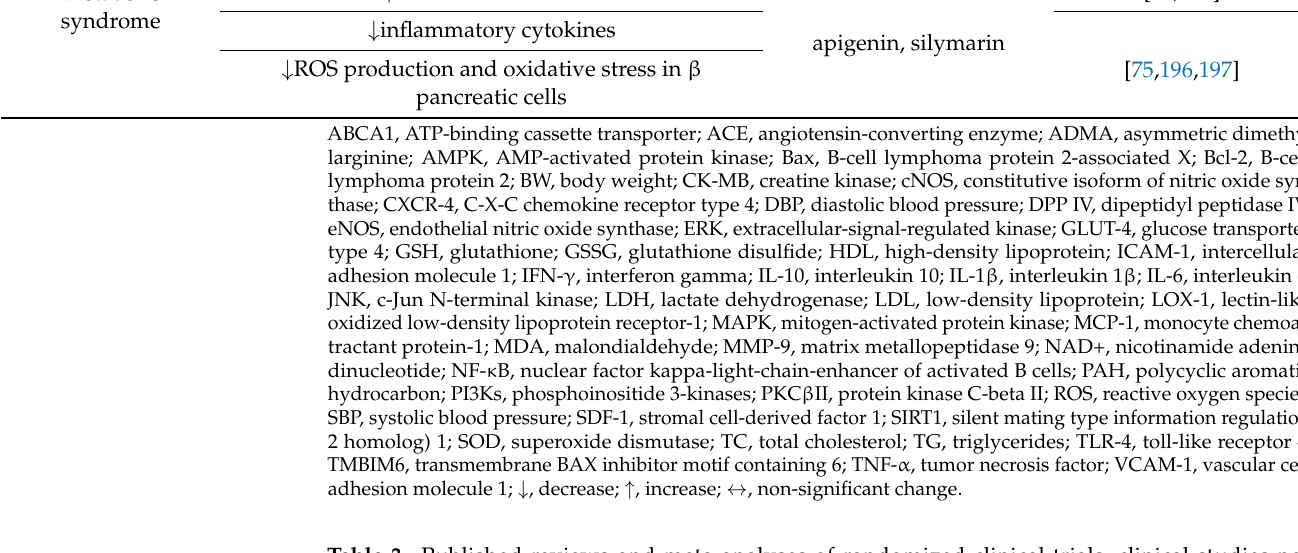
Table 3. Published reviews and meta-analyses of randomized clinical trials, clinical studies not included in meta-analyses, and a cohort study based on the cardioprotective properties of apigenin, quercetin, and